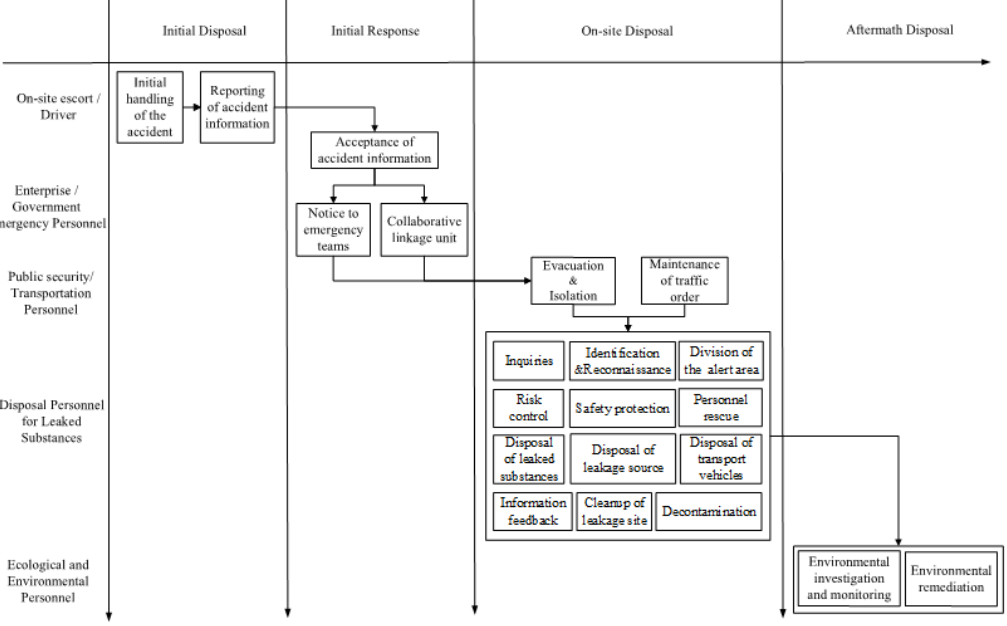
Figure 3. Emergency activities in 54 accident cases.